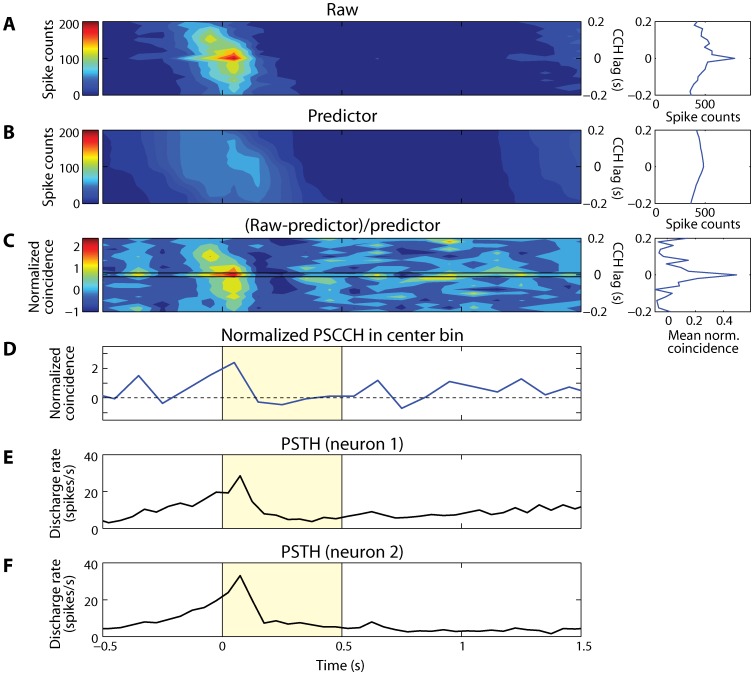
Peri-stimulus cross-correlation histograms (PSCCHs).
A) Raw PSCCH of a dlPFC neuron pair. Horizontal bin size is 100 ms and vertical (CCH) bin size is 20 ms. The right panel illustrates a sum of the coincident spikes over time shown in the left panel. B) Predictor PSCCH of the same neuron pair. Predicted value of coincident spikes between the pair of neurons is plotted as a function of time. The predictor was estimated by correcting the raw PSCCH with a surrogate spike train method in which the spike time was randomly resampled (see methods). The right panel illustrates a sum of the coincident spikes over time shown in the left panel. C) Normalized PSCCH. The raw PSCCH was normalized by subtracting predictor and divided by predictor, bin-by-bin. Horizontal two lines represent the edges of center 20 ms bin. The right panel illustrates an average of normalized coincident spikes over time shown in the left panel. D) Normalized coincident spikes occurred within the center bin depicted in C. Yellow shaded area represents the cue presentation time. E-F) Raw peri-stimulus time histograms (PSTHs) of two dlPFC neurons separately. Firing rate of each neuron in the pairs used to plot PSCCH in this example is plotted as a function of time. The bin size is 50 ms.